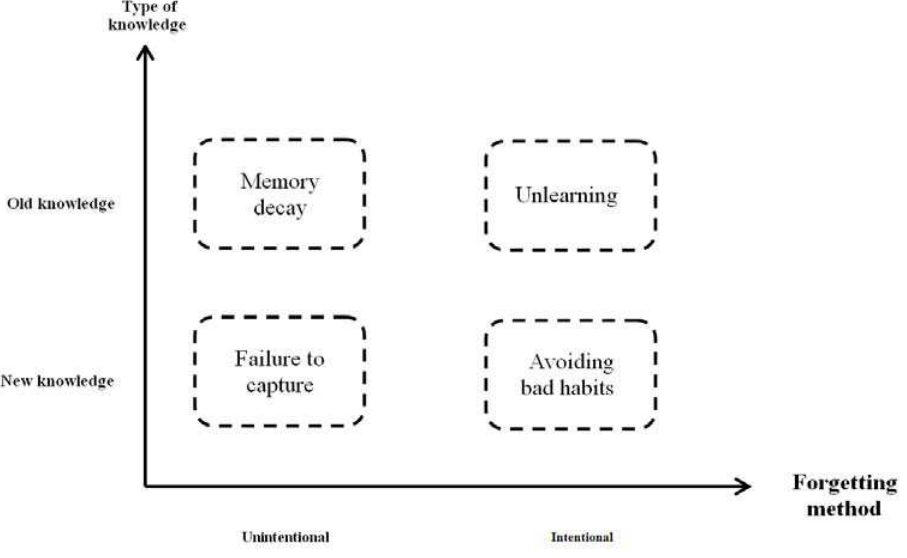
Fig. 1. Aspects of organizational forgetting